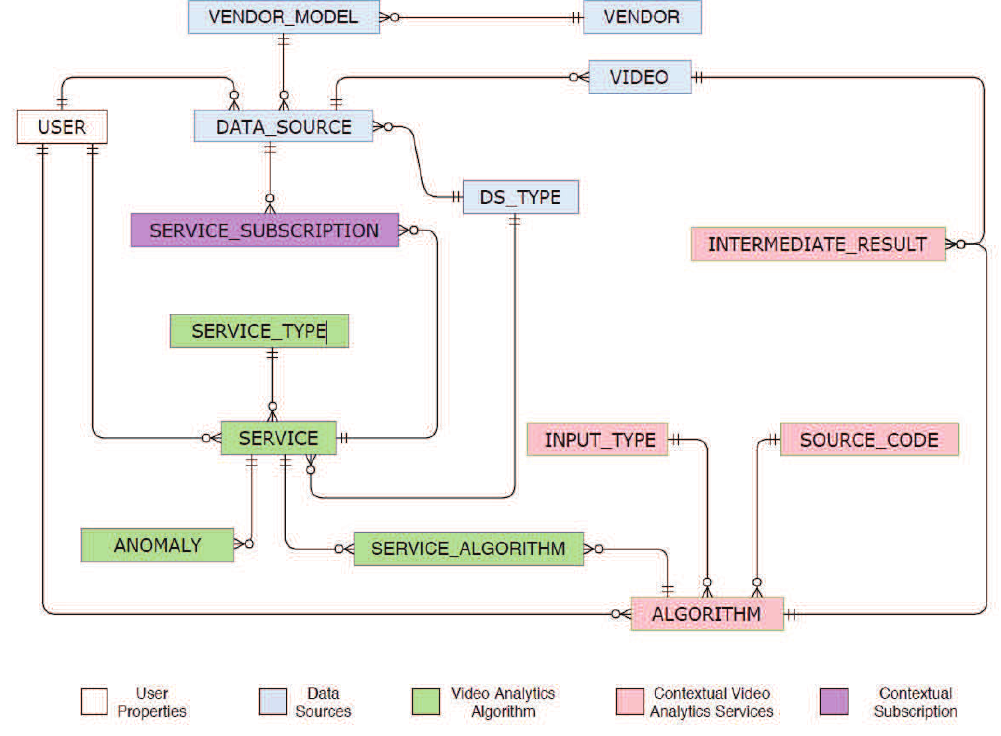
Figure 6. Immediate Structured Big Data Store